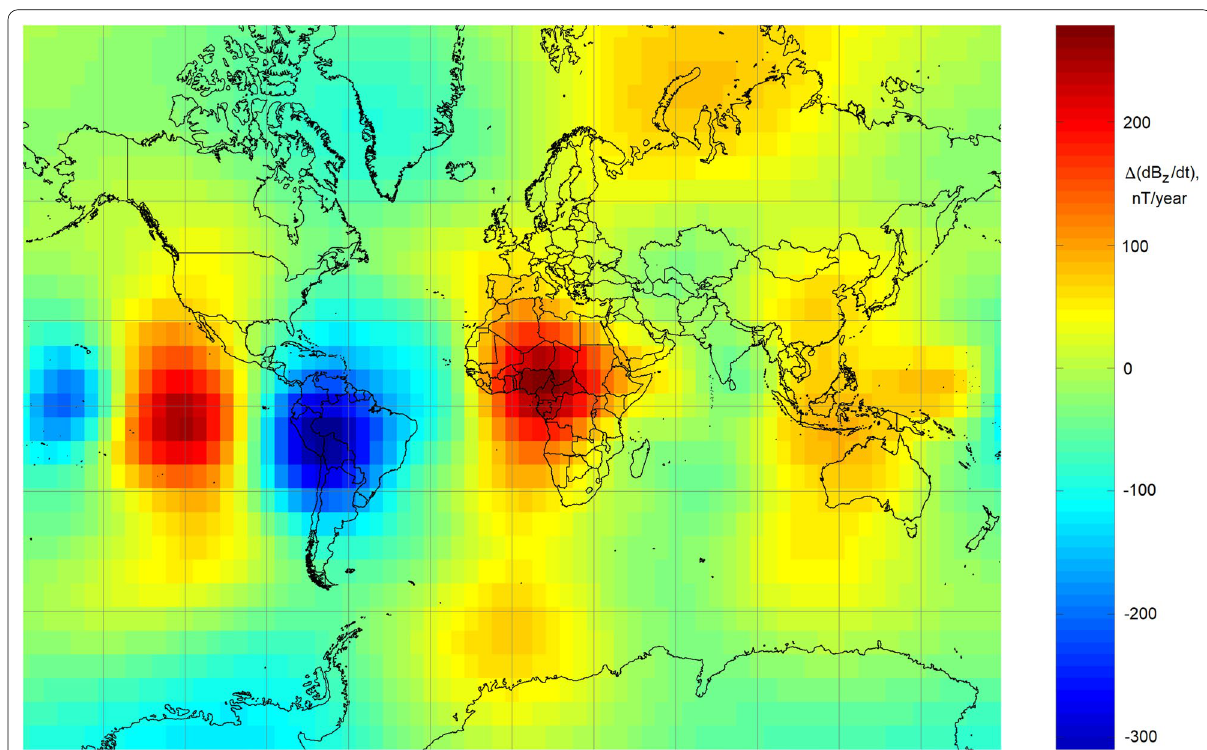
Fig. 6 Comparison of the 1964–1970 SV of the Z component based on the M-1 and M-2 models with the 1965–1970 SV derived from the IGRF model. The map shows the differences of the SV (Z) calculated at the nodes of the regular geographic grid at a spherical surface with the mean Earth radius, 6371.2